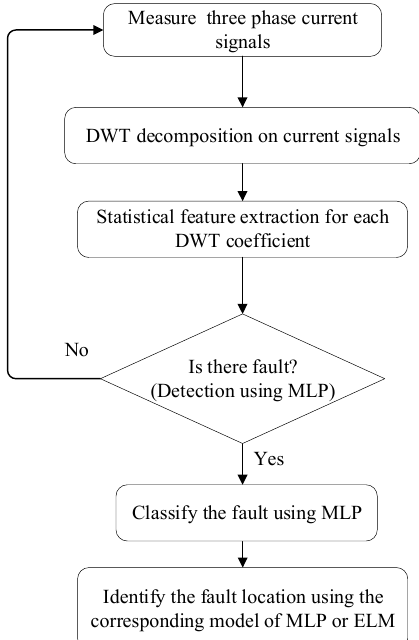
Figure 1. Fault detection, classification, and location flowchart employing the discrete wavelet transform (DWT) approach.